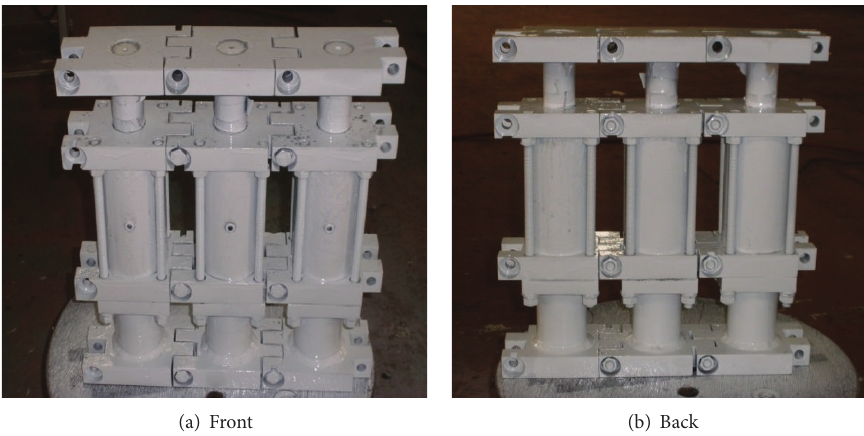
Figure 2: Assembled TSD with three slim-type dampers.